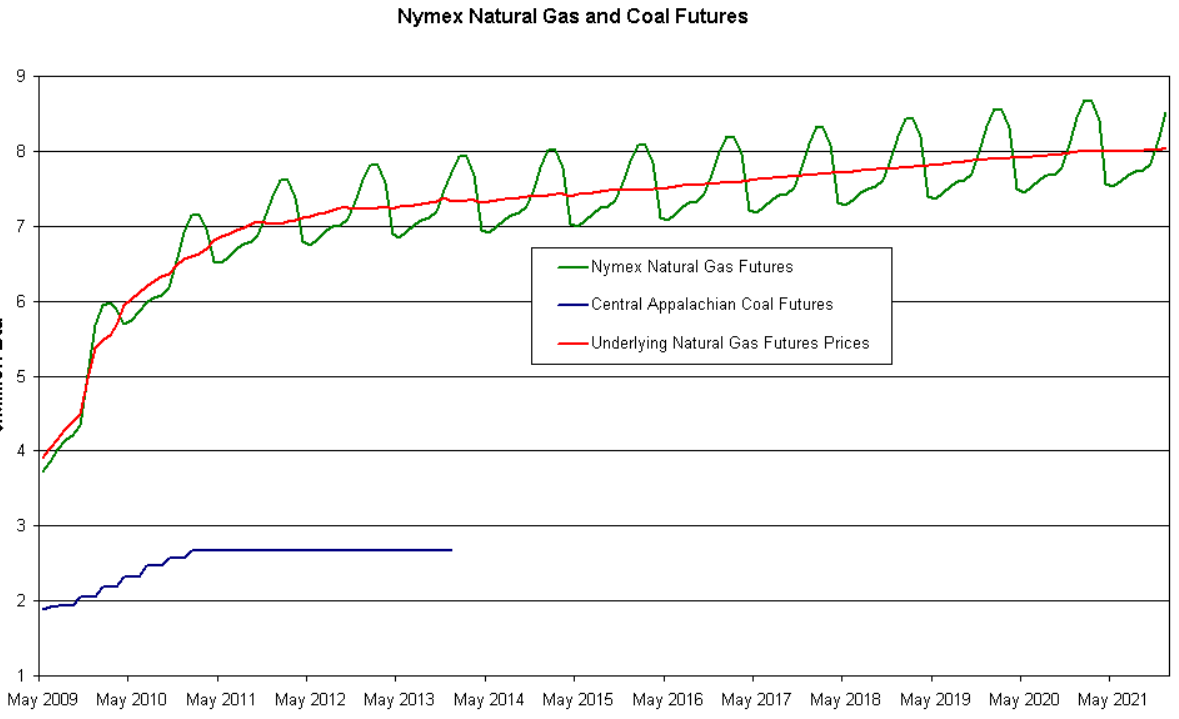
Figure 5. Price of futures contracts on natural gas and coal. Source: